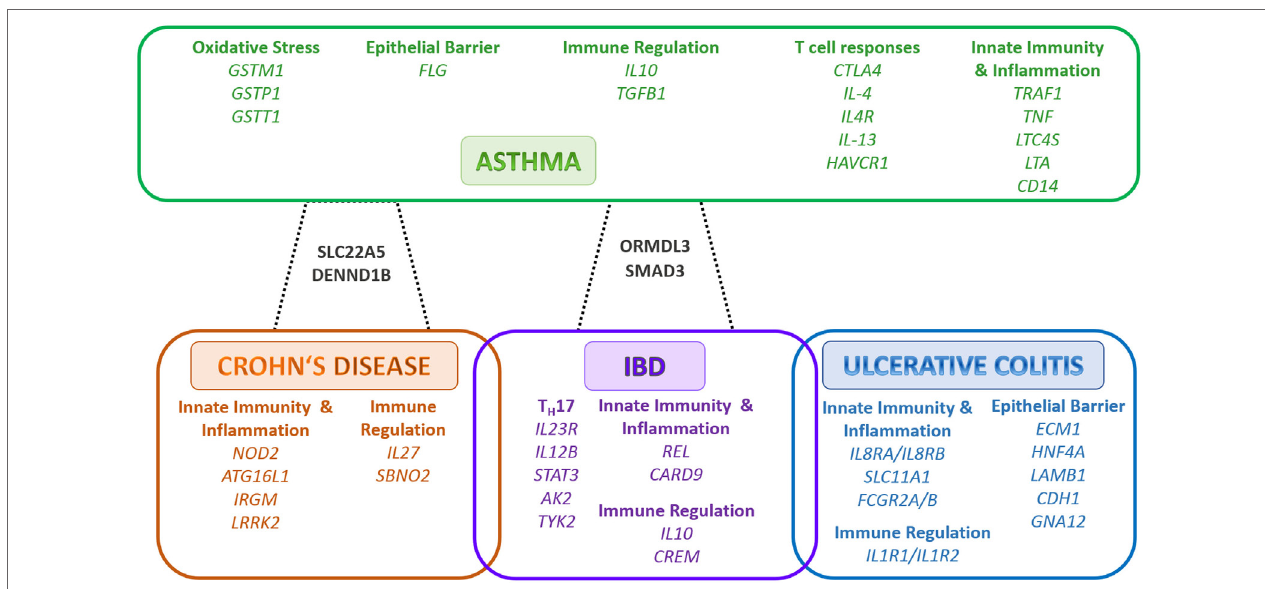
FiGURe 1 | Shared and individual inflammatory bowel disease (IBD) and Asthma susceptibility genes/loci. The outlined genes are grouped according to function. In green color are the genes associated to asthma, in blue color are the genes associated to ulcerative colitis only, in orange color are the genes associated to Crohn’s disease only, in purple color are the genes associated to IBD, in black color are the genes associated to asthma and Crohn’s disease or asthma and IBD, respectively. Adapted from Ref. (37–40). Abbreviations: AK2, adenylate kinase 2; ATG16L1, autophagy related 16 like 1; CARD9, caspase recruitment domain family member 9; CD14, cluster of differentiation 14; CDH1, cadherin 1; CREM, CAMP responsive element modulator; CTLA4, cytotoxic T-lymphocyte associated protein 4; DENND1B, DENN domain containing 1B; ECM1, extracellular matrix protein 1; FCGR2A, Fc fragment of IgG receptor IIa; FCGR2B, Fc fragment of IgG receptor IIb; FLG, filaggrin; GNA12, G-protein subunit alpha 12; GSTM1, glutathione S-transferase mu 1; GSTP1, glutathione S-transferase pi 1; GSTT1, glutathione S-transferase theta 1; HAVCR1, hepatitis A virus cellular receptor 1; HNF4A, hepatocyte nuclear factor 4 alpha; IL-13, interleukin 13; IL-4, interleukin 4; IL-10, interleukin 10; IL-12B, interleukin 12B; IL-1R1, interleukin 1 receptor type 1; IL-1R2, interleukin 1 receptor type 2; IL23R, interleukin 23 receptor; IL-27, interleukin 27; IL-4R, interleukin 4 receptor; CXCR1, C–X–C motif chemokine receptor 1; CXCR2, C–X–C motif chemokine receptor 2; IRGM, immunity related GTPase M; LAMB1, laminin subunit beta 1; LRRK2, leucine rich repeat kinase 2; LTA, lymphotoxin alpha; LTC4S, leukotriene C4 synthase; NOD2, nucleotide binding oligomerization domain containing 2; ORMDL3, ORMDL sphingolipid biosynthesis regulator 3; REL, REL proto-oncogene, NF- κ B subunit; SBNO2, strawberry notch homolog 2; SLC11A1, solute carrier family 11 member 1; SLC22A5, solute carrier family 22 member 5; SMAD3, SMAD Family Member 3; STAT3, signal transducer and activator of transcription 3; Th, T helper cell; TGFB1, transforming growth factor beta 1; TNF, tumor necrosis factor; TRAF1, TNF receptor associated factor 1; TYK2, tyrosine kinase